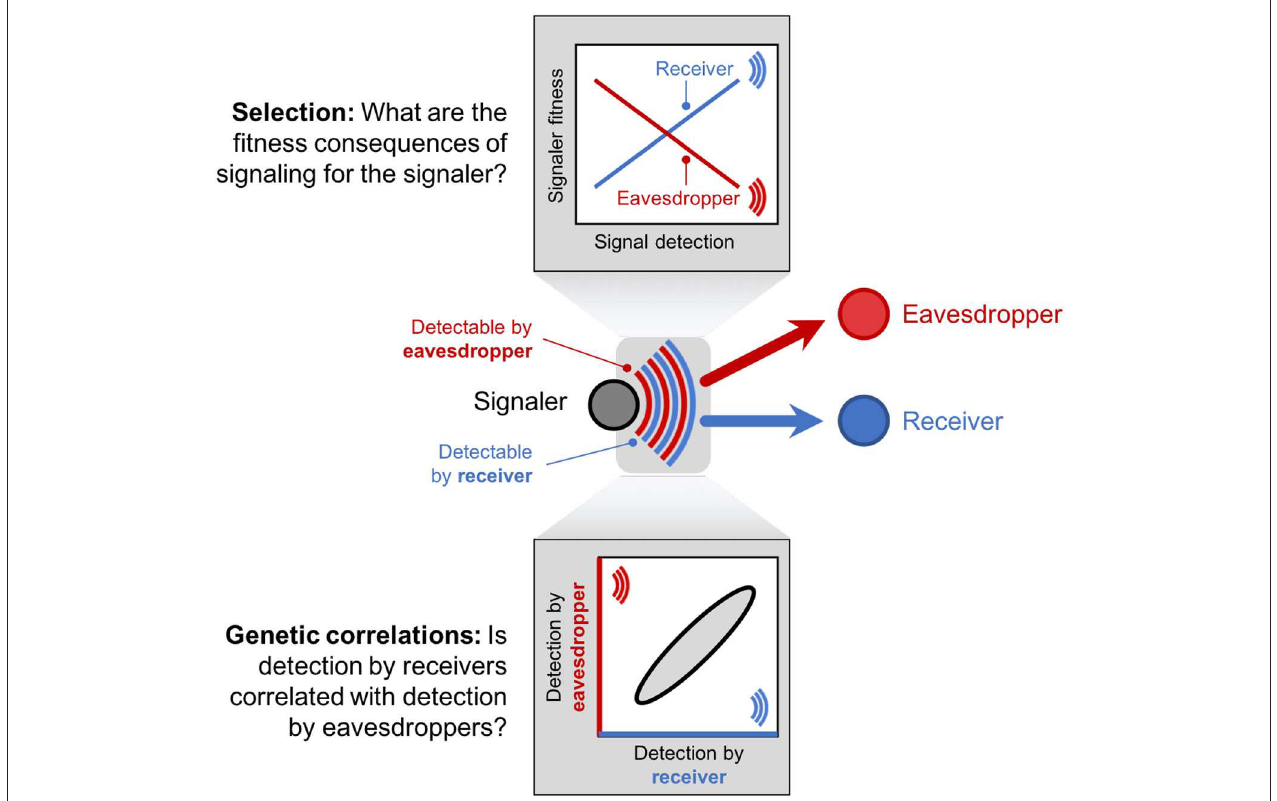
FIGURE 3 | Signal evolution is governed by two elements: selection (the fitness consequences of signaling for the signaler) and genetic correlations (the relationship between signal detectability by receivers and signal detectability by eavesdroppers). Selection (top) imposed by eavesdroppers can be quantified by measuring the relationship between signaler fitness and signal detection by eavesdroppers. Genetic correlations (bottom) can be measured by treating signal detectability by eavesdroppers and receivers (the blue and red components of the signal in this diagram) as two separate traits in the signaler (i.e., two separate properties of the signal itself). When signal detection by eavesdroppers is positively correlated with detection by receivers, as illustrated in this example, eavesdroppers will influence how signaler-receiver communication